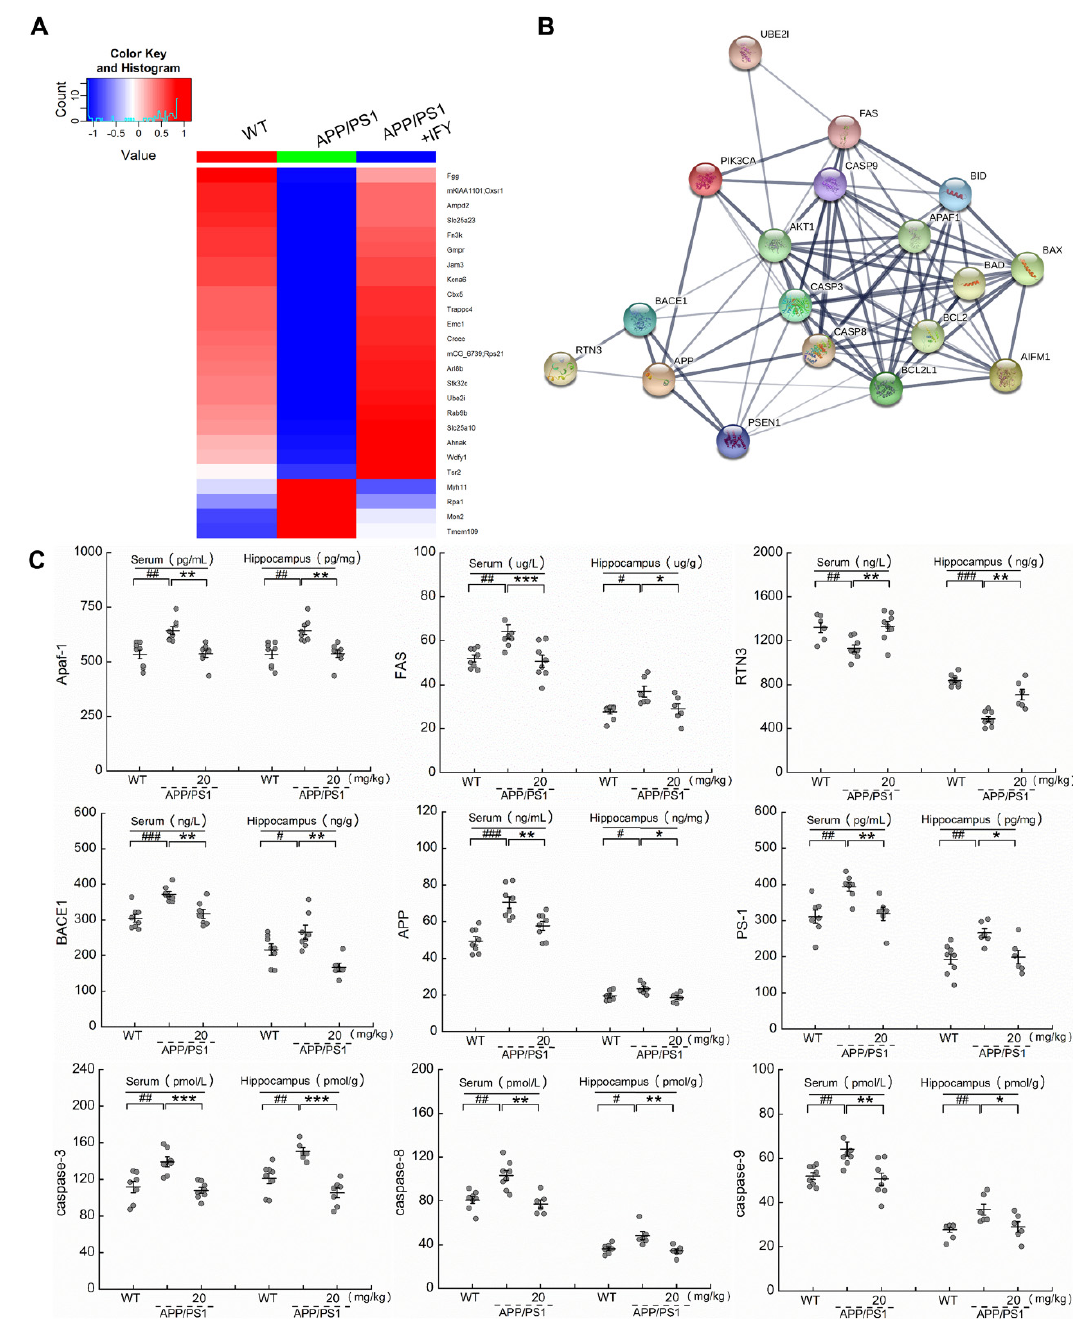
Figure 4. IFY regulated the expressions of apoptosis-related proteins in the serum and hippocampus. ( A ) Color-coded two-dimensional heat maps among WT, APP/PS1 and IFY-treated APP/PS1. Red represents up-regulated protein expression values, and blue represents down-regulated values ( n = 6). ( B ) STRING protein interactive analysis for the interaction analysis of differentially expressed proteins among WT, APP/PS1 and IFY-treated APP/PS1. The thickness of the line indicates the strength of data support. ( C ) IFY ameliorated apoptosis related proteins including Apaf-1, FAS, RTN3, BACE1, APP, PS-1, caspase-3, caspase-8 and caspase-9 detected by an enzyme-linked immunosorbent assay (ELISA ( n = individual dots displayed for each group in all graphs)). All data shown as the mean ± SEM. # p < 0.05, ## p < 0.01, ### p < 0.001 vs. WT mice, * p < 0.05, ** p < 0.01, *** p < 0.001 vs. APP/PS1 mice. 2.5. The Activation of PI3K/AKT Signaling is Involved in IFY-Regulated Anti-Apoptosis